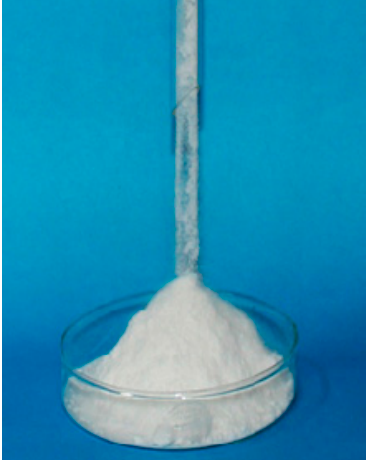
Figure 2. Free-flowing HSCP-70 from a glass funnel.